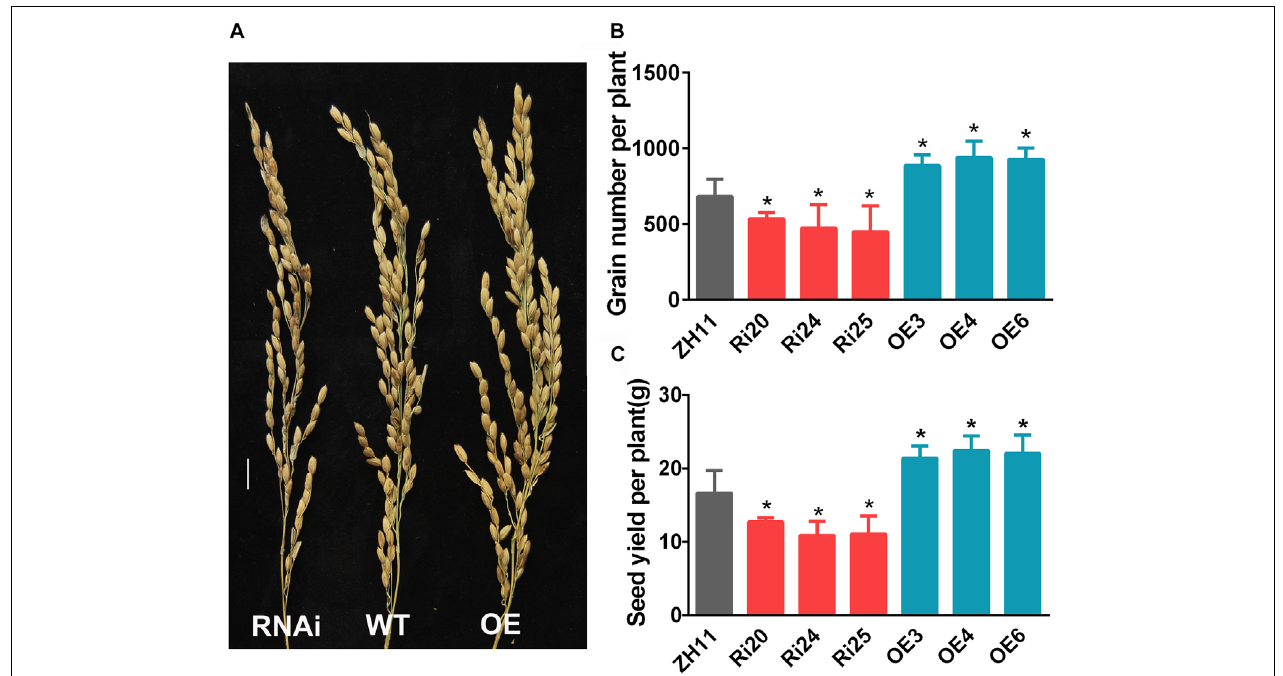
FIGURE 5 | OsATG8b affects rice grain yield. OsATG8b -RNAi (Ri) and OsATG8b -OE (OE) lines and ZH11 were grown in the paddy field with normal fertilizer. (A–C) Panicle architecture (A) , grain number (B) , and grain yield (C) per plant of OsATG8b- RNAi and OsATG8b -OE lines and ZH11. Bar = 1 cm. Three biological replicates, each containing 80 plants, were used for data analysis. Results are the mean ± SD from 80 plants. * p < 0.05 ( t -test): significantly different from